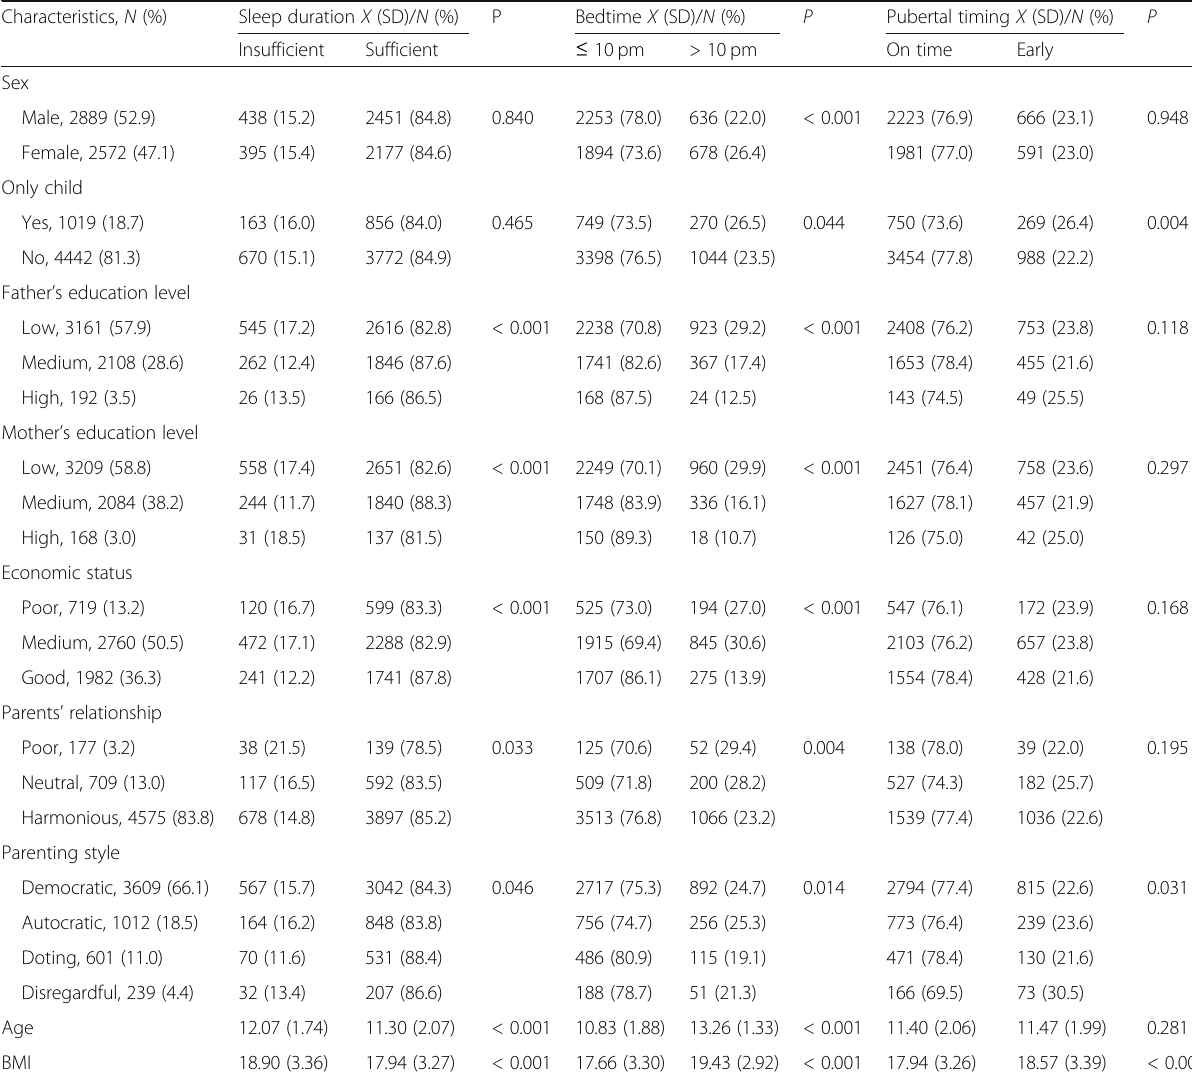
Table 2 Characteristics of adolescents with regard to sleep duration, bedtime, and pubertal timing Characteristics, N (%) Sex Male, 2889 (52.9) Female, 2572 (47.1) Only child Yes, 1019